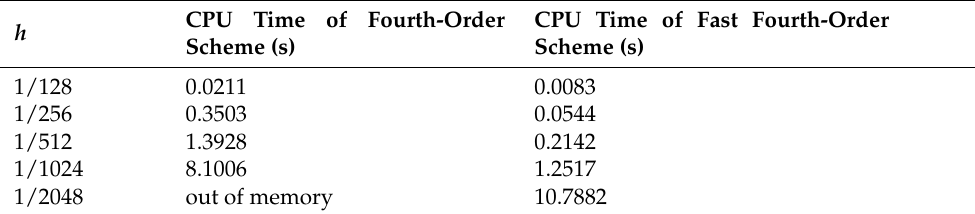
Table 4. The comparison of the computational time for the proposed normal and fast fourth- order scheme.